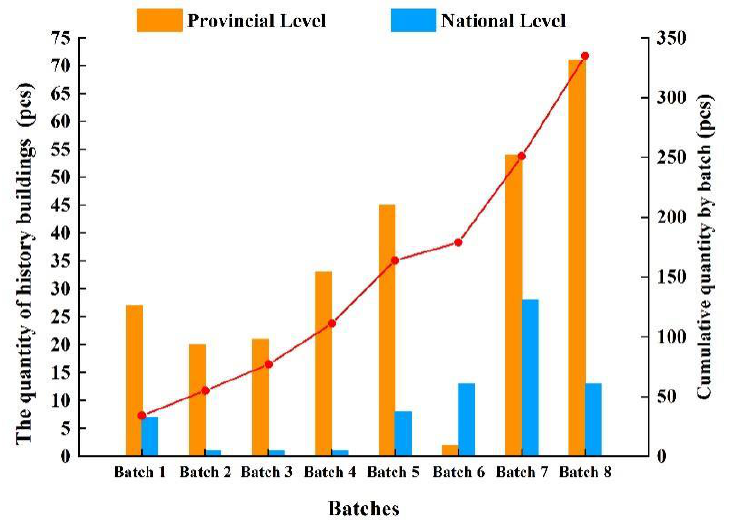
Figure 17. The quantity of national and Henan provincial historical buildings by batches in the Songshan region.